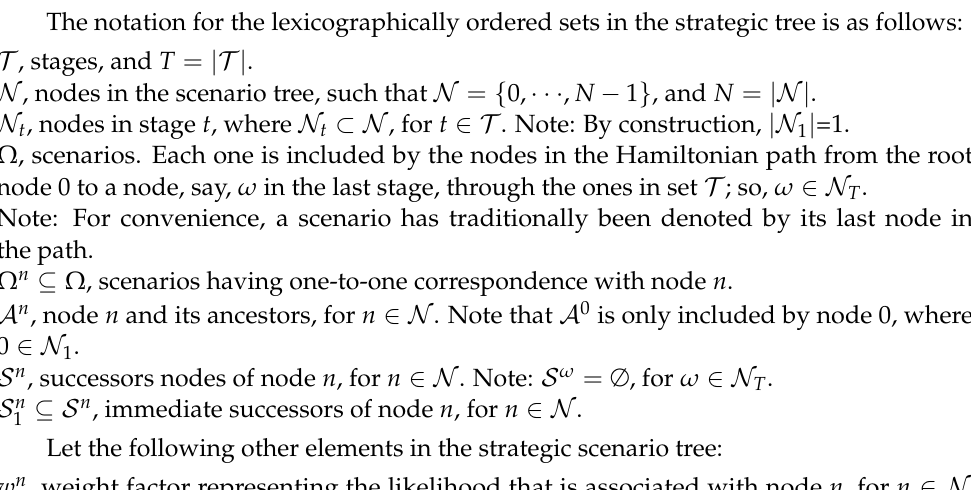
Figure 2. Strategic multistage scenario